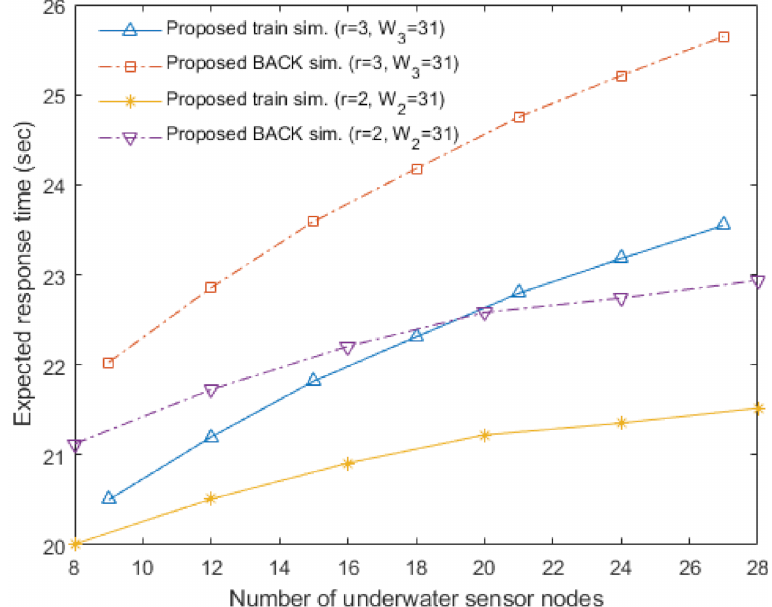
Figure 7. Expected response time of the proposed underwater multi-DATA train protocol with r = 2 and r = 3, and the proposed underwater BACK protocol with r = 2 and r = 3 when W r =